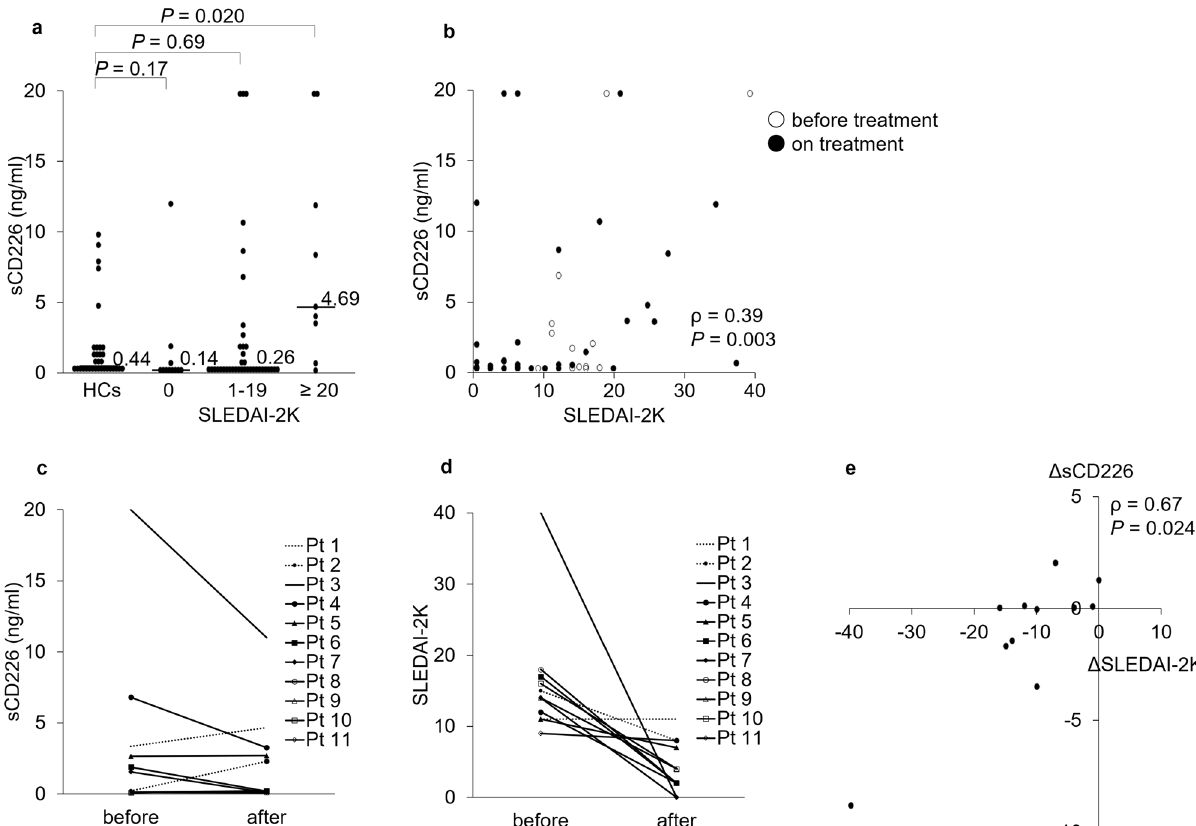
Figure 2. Associations between serum sCD226 levels and SLEDAI-2K scores. ( a ) Serum sCD226 levels were compared between SLE patients with SLEDAI-2K scores of 0, 1–19, and ≥ 20, as well as HCs. ( b ) Correlations between serum sCD226 levels and SLEDAI-2K scores in SLE patients. ( c ) Serum sCD226 levels before and after treatment in 11 SLE patients. ( d ) SLEDAI-2K scores before and after treatment in 11 SLE patients. ( e ) Correlations between the ΔsCD226 and the ΔSLEDAI-2K scores in SLE patients. Each data point represents a single subject. Horizontal lines show the median. Statistical differences among groups were evaluated